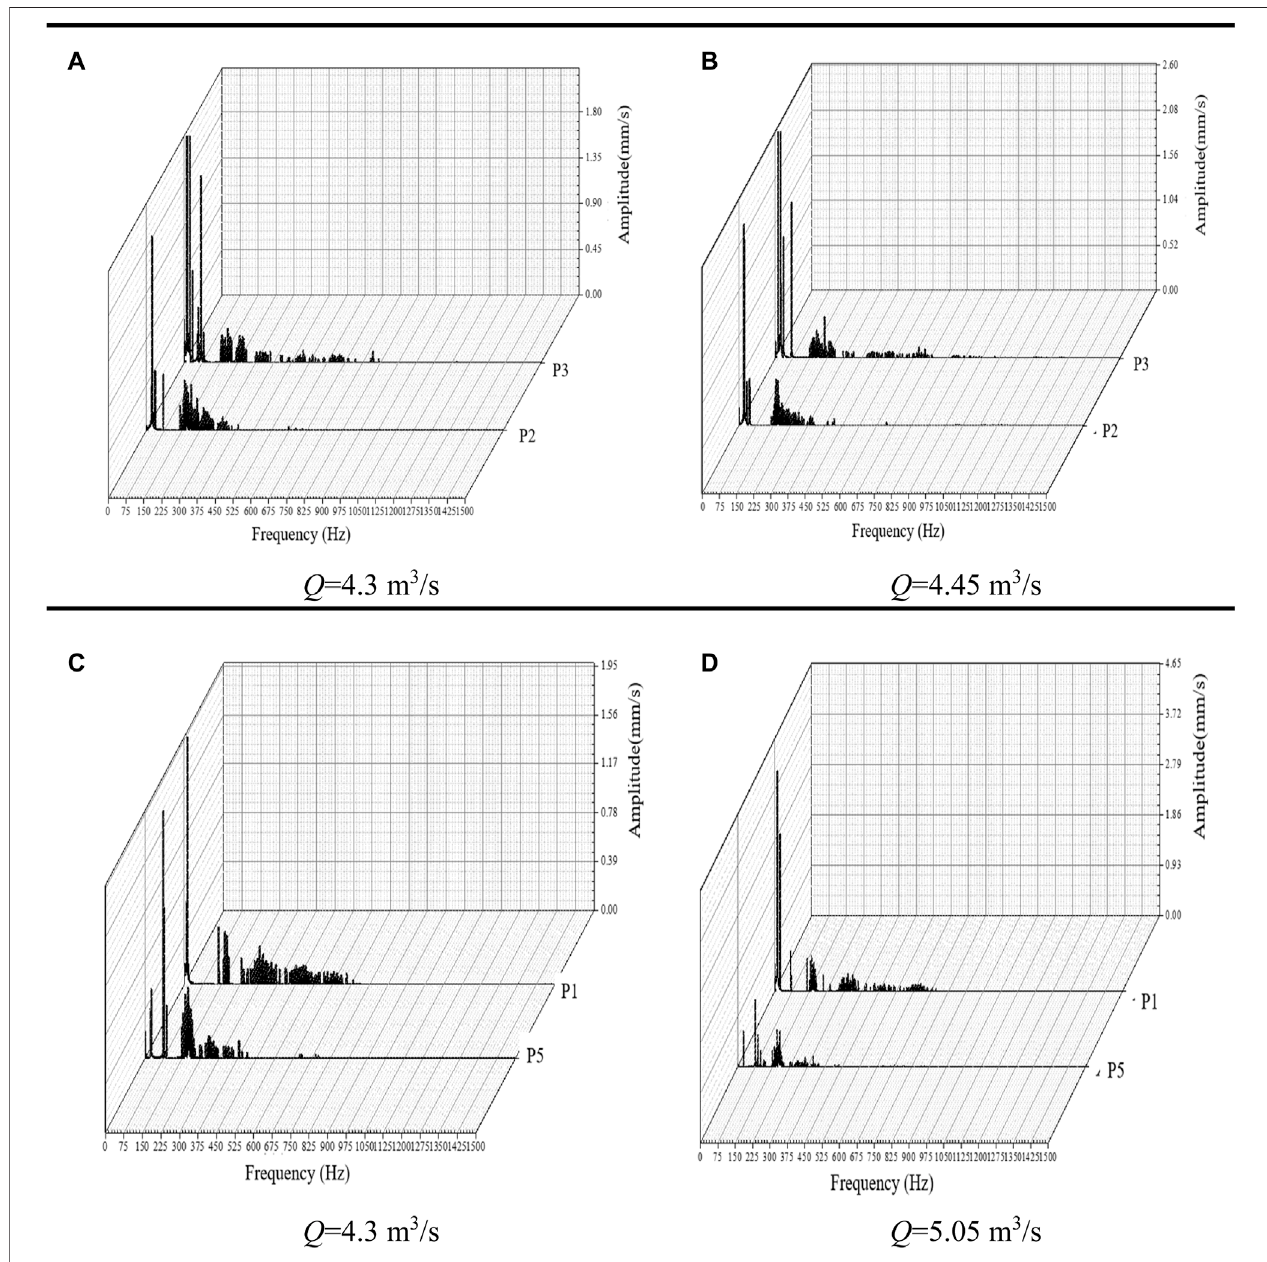
FIGURE 12 | Velocity frequency spectra at P3 for each fl ow condition. Q in represents different fl ow rates.